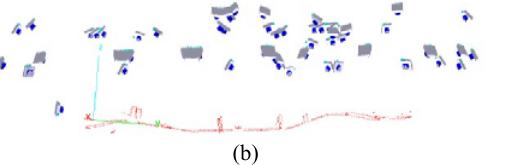
Figure 4. Network structure created for produced chassis from top view(a), and side view (b)